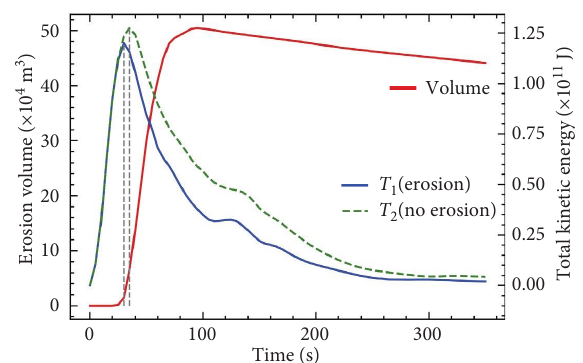
Figure 11: Te erosion volume and kinetic energy characteristics of the landslide in